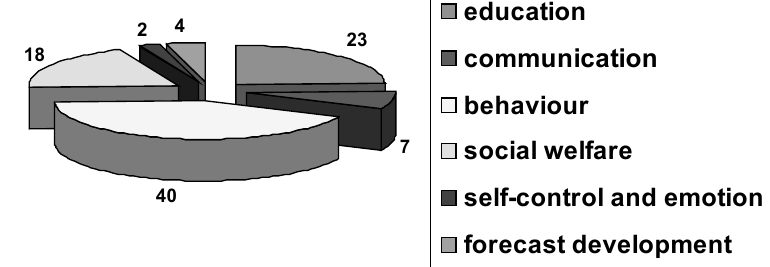
Fig. 2. Distribution of parents answers as to the main problems of autistic children. Source:Own chart. Analysis of (cid:222) gure 2 shows that in contrast to the teachers, the parents